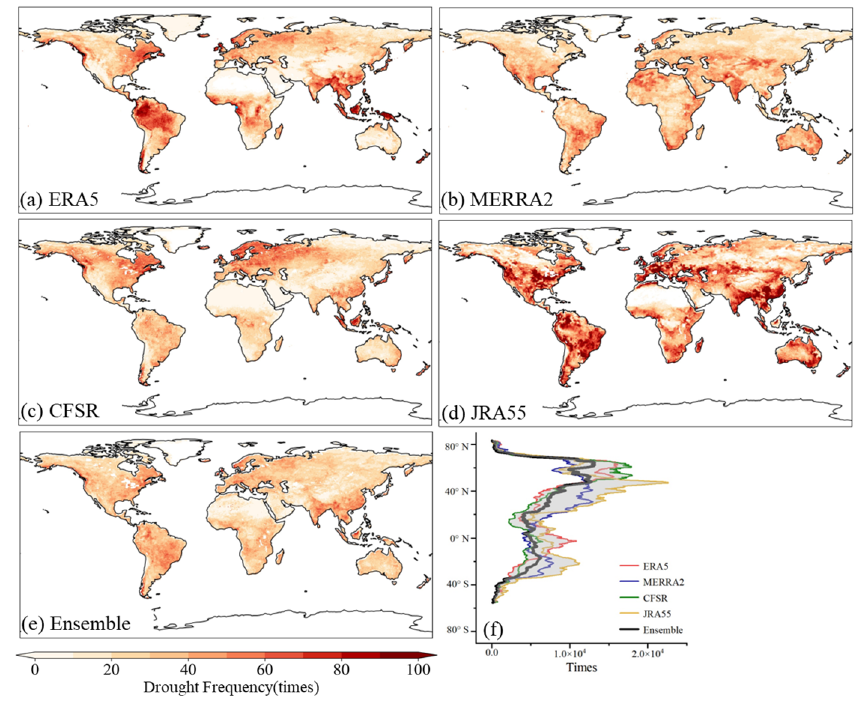
Figure 4. Spatial distributions of the accumulated drought frequency (unit: times) from 1980 to 2019 derived from ERA5 ( a ), MERRA2 ( b ), CFSR ( c ), JRA-55 ( d ), and the averaged ensemble ( e ). Latitudinal distribution is shown in ( f ).